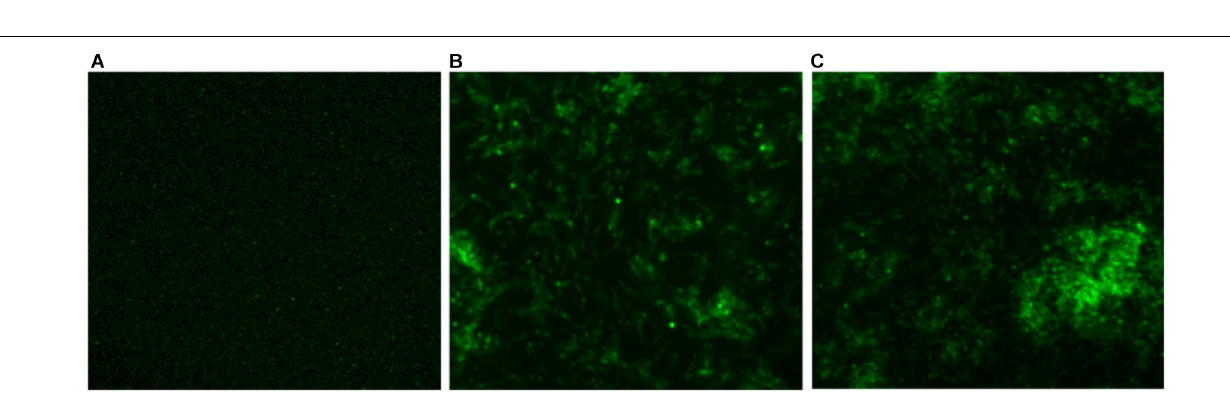
FIGURE 4 | Fluorescence micrograph showing the generation of intracellular reactive oxygen species (ROS) using DCFDA dye in CNPs treated M. smegmatis cells (A) . Control (B,C) cells exposed to CNP and CNP-L at prefix MIC dose for 6 h showing increases in fluorescence intensity demonstrating excess generation of ROS